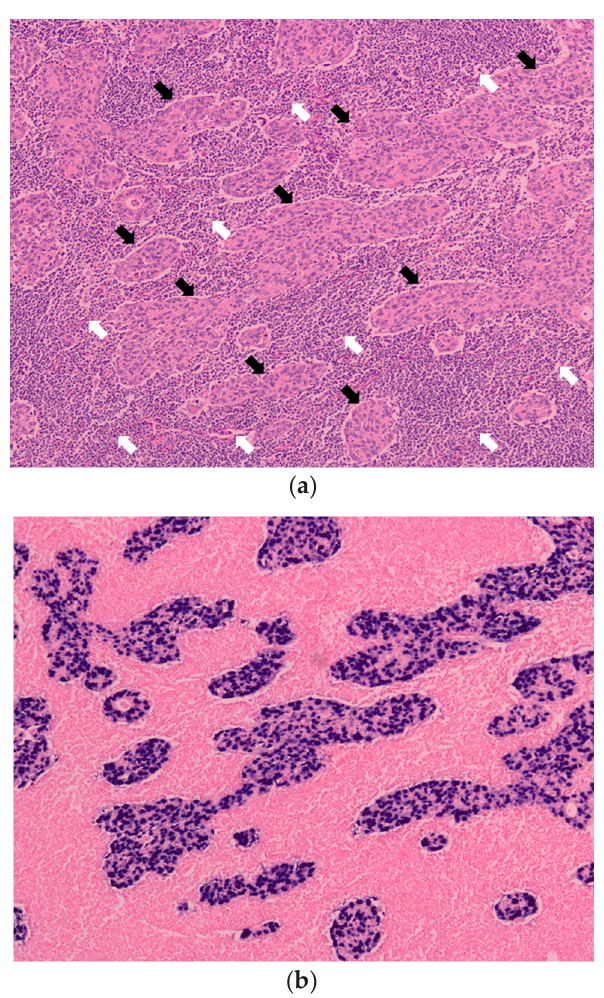
Figure 1. Histologic characteristics of Epstein-Barr virus-associated gastric carcinoma (EBVaGC). ( a ) Histology of carcinoma with lymphoid stroma (CLS). Undifferentiated adenocarcinomas (black arrows) are surrounded by infiltrating lymphocytes (white arrows). (H&E staining); ( b ) EBV-encoded small ribonucleic acid 1 in situ hybridization (EBER-1 ISH). Signals of EBER-1 are observed in nuclei of the carcinoma cells indicated by black arrows in ( a ). Infiltrating lymphocytes in the stroma indicated by white arrows in ( a ) are EBER-1 negative. Magnification ( a ) and ( b )( ×